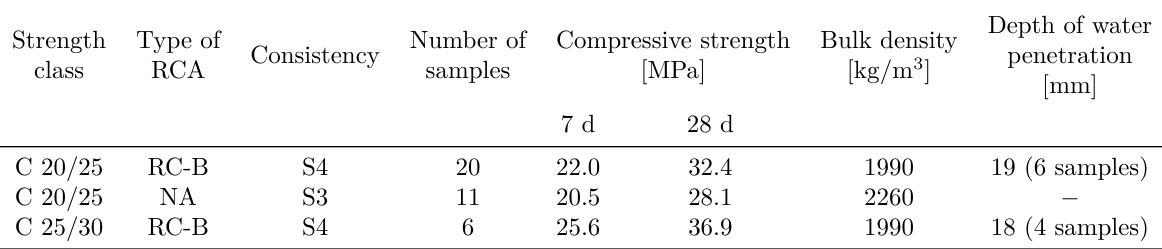
Table 3. Average results of operating tests during industrial production.